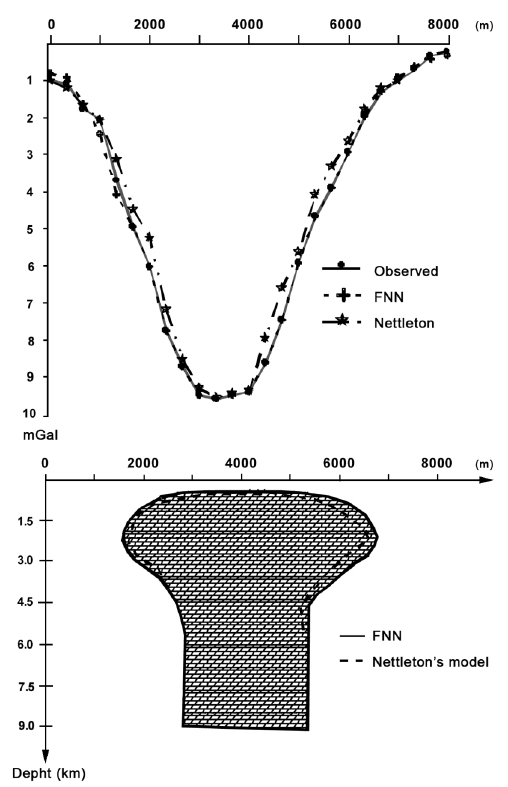
Fig. 6. Inferred structure of salt dome believed to be causing offshore gravity anomaly of fig. 5. Agree- ment between observed and calculated gravity pro- files supports choice of model for structure (for AB cross-section; - • - observed anomaly; - ++ - FNN output; - (cid:1)(cid:1) -Nettleton